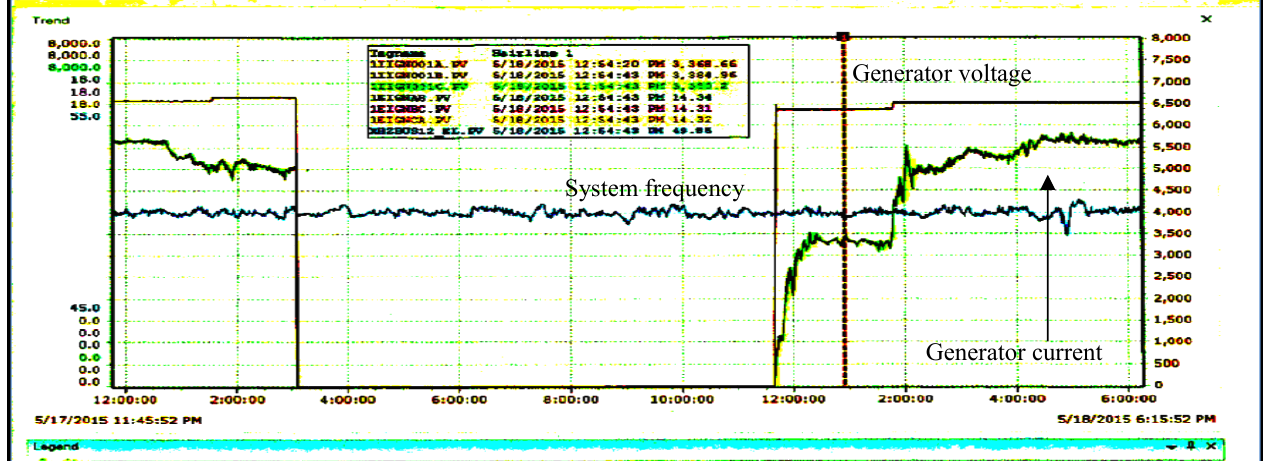
Fig 3. Voltage Current and Frequency for Unit No.1 Generator